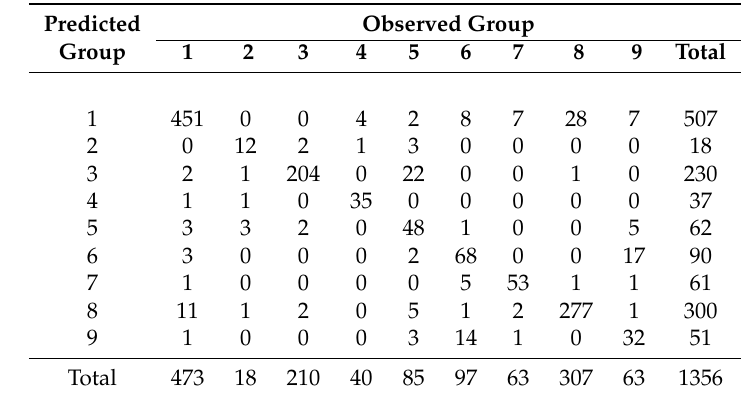
Table 5. An example of confusion matrix, 15 Sentinel-1 scenes, 1 June–30 August, nine species groups, minimum area 2 ha, observed on coloumns, predicted on rows.